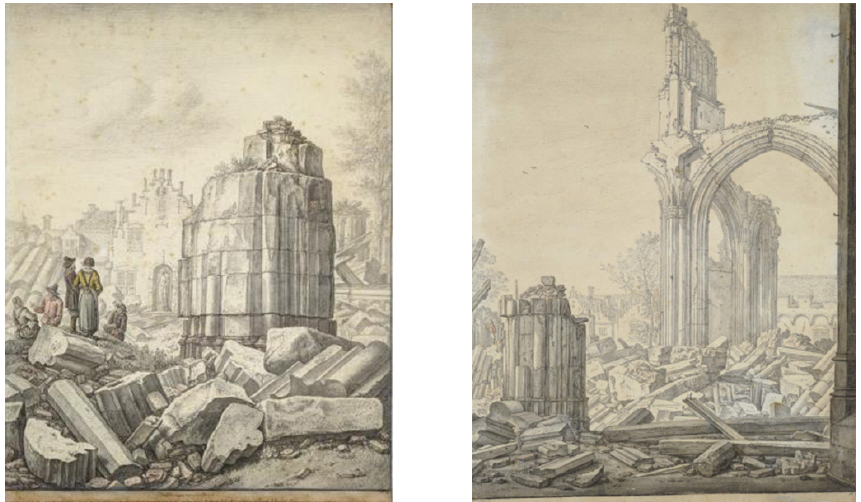
Figure 4. Drawing of the ruin of the Dom cathedral following the 1674 storm by Herman Saftleven (Utrecht City Archive no. 28637 and no. 28630, both views from the